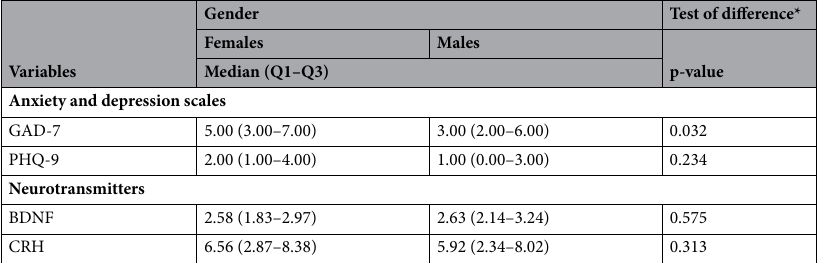
Table 3. Characteristics of vitiligo patients stratified by gender. *—test of difference was Mann Whitney U-test. GAD-7—Generalized Anxiety Disorder 7-item Scale. PHQ-9—The Patient